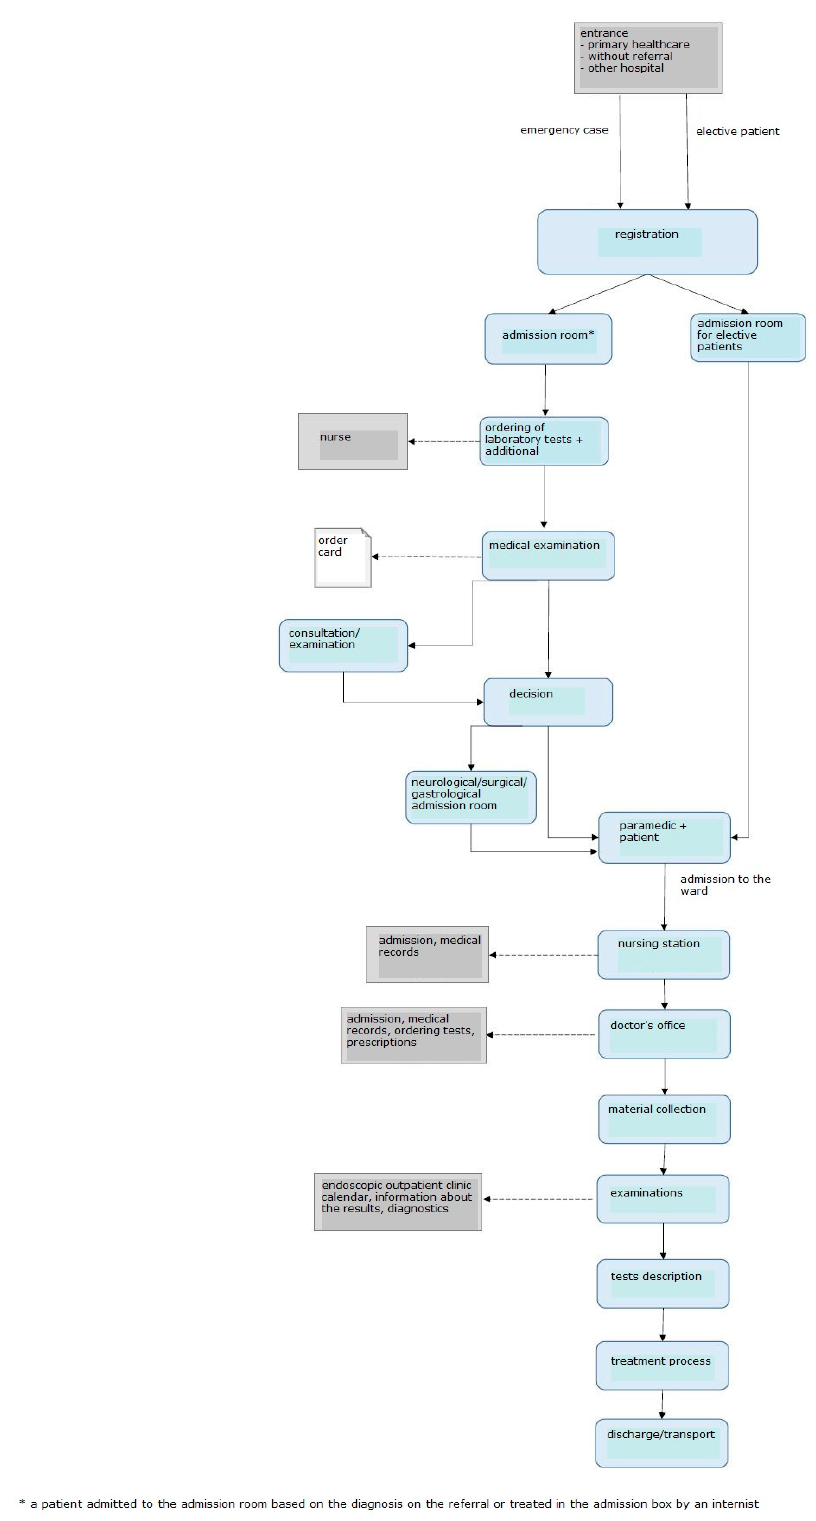
Figure 8. The scheme of admitting the patient after the changes have been made. Source: own study.